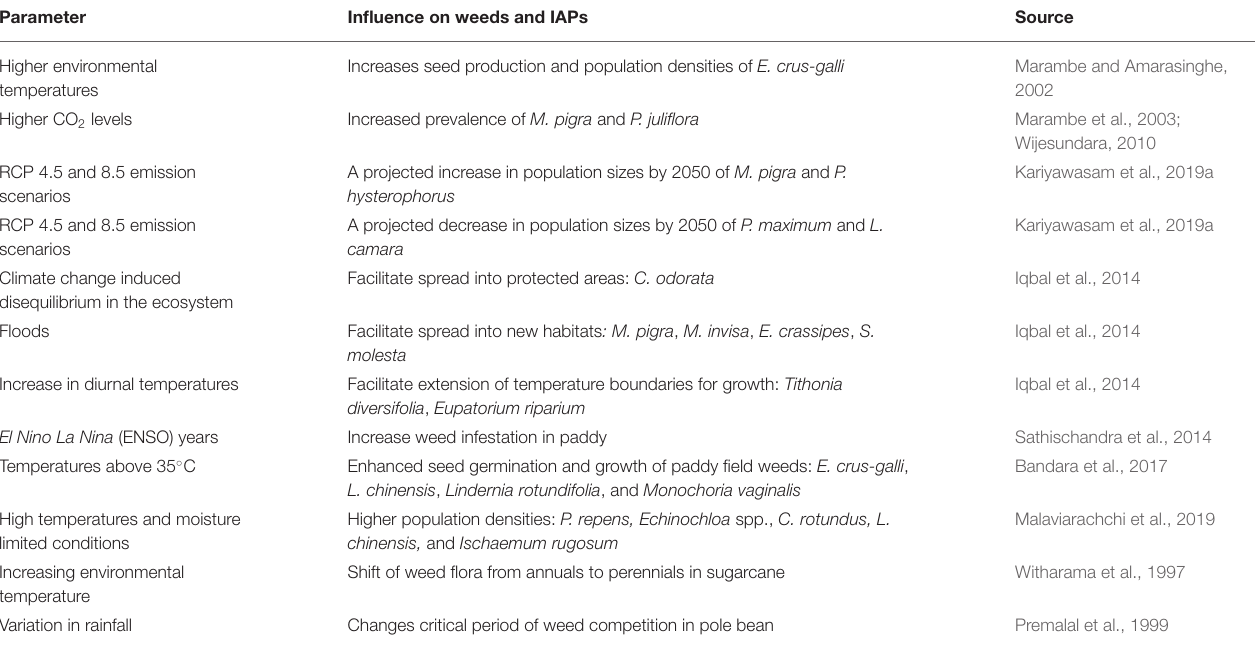
TABLE 5 | Invasive behavior of alien plants as affected by climate change and resulting changes in the environment (this is a representative list; the outcomes are based on scientific studies and